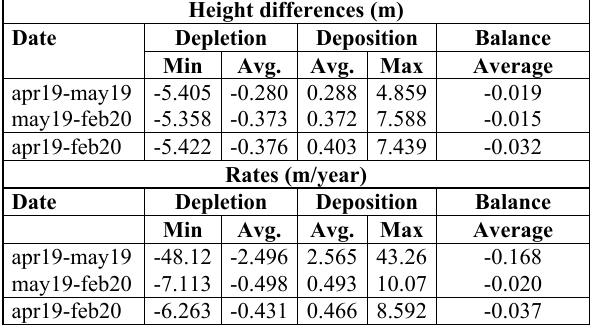
Table 5. Height differences and rates in the gully area.